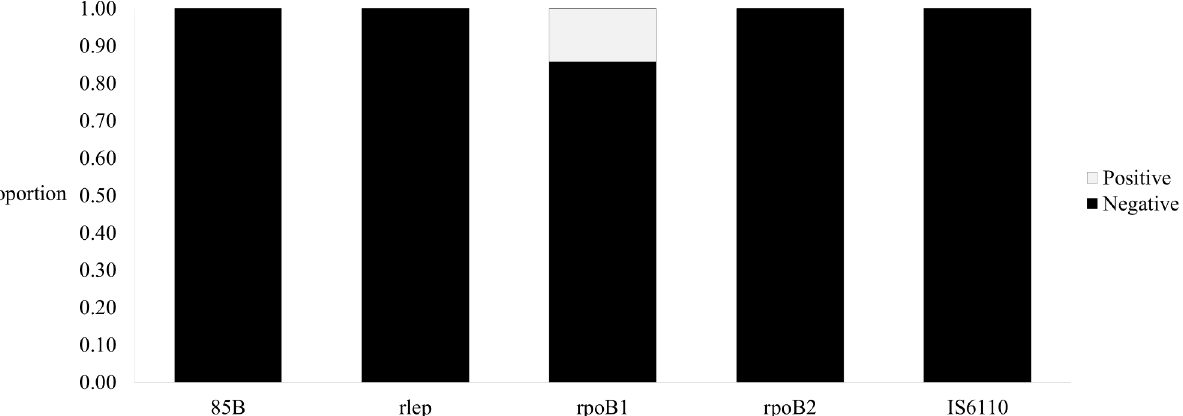
Fig 3. Overall qPCR results for case study. qPCR results for marmoset samples (n = 98). All marmosets were negative for the M . leprae -specific 85B and rlep genes and the MTBC-specific rpoB2 and IS6110 genes. However, 14 are positive for the mycobacterial rpoB1 gene. Approximately 0.001 – 0.137 mycobacterial genome copies per ng of DNA extracted were identified from these rpoB1-positive samples.